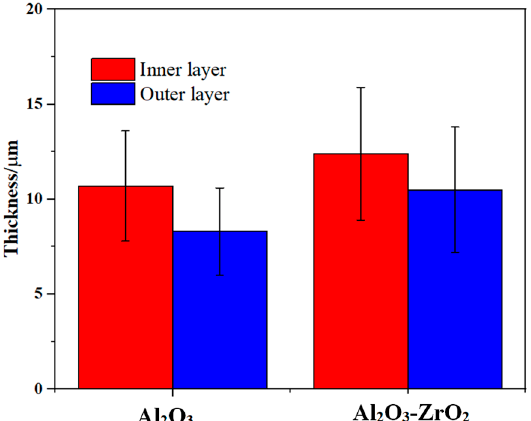
Figure 5. Average value and standard deviation of the thickness of the outer and inner layers of the reference coating and the coating prepared in the Zr electrolyte extracted from the cross-section images in Figure 4. The formed composite coating exhibited a higher thickness for identical processing time, when compared to the reference coating.